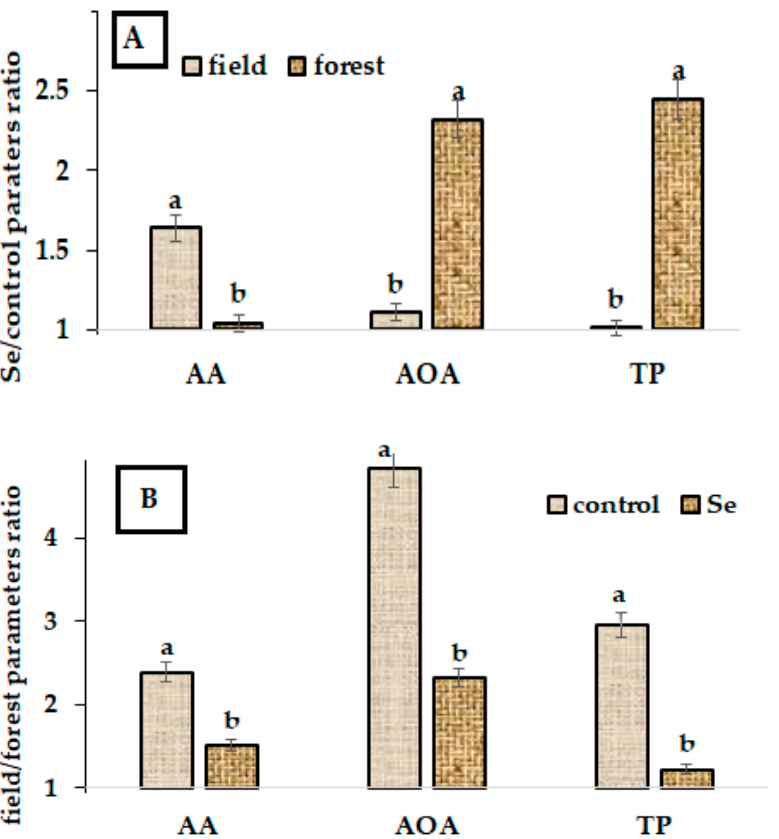
Figure 2. Ascorbic acid (AA), polyphenol content (TP), and total antioxidant activity (AOA) changes in ramson leaves as affected by ( A ) Se supply (Se fortified/control) and ( B ) place of habitat (field/forest). For each parameter, values with different letters differ statistically according to Duncan test at p < 0.05.